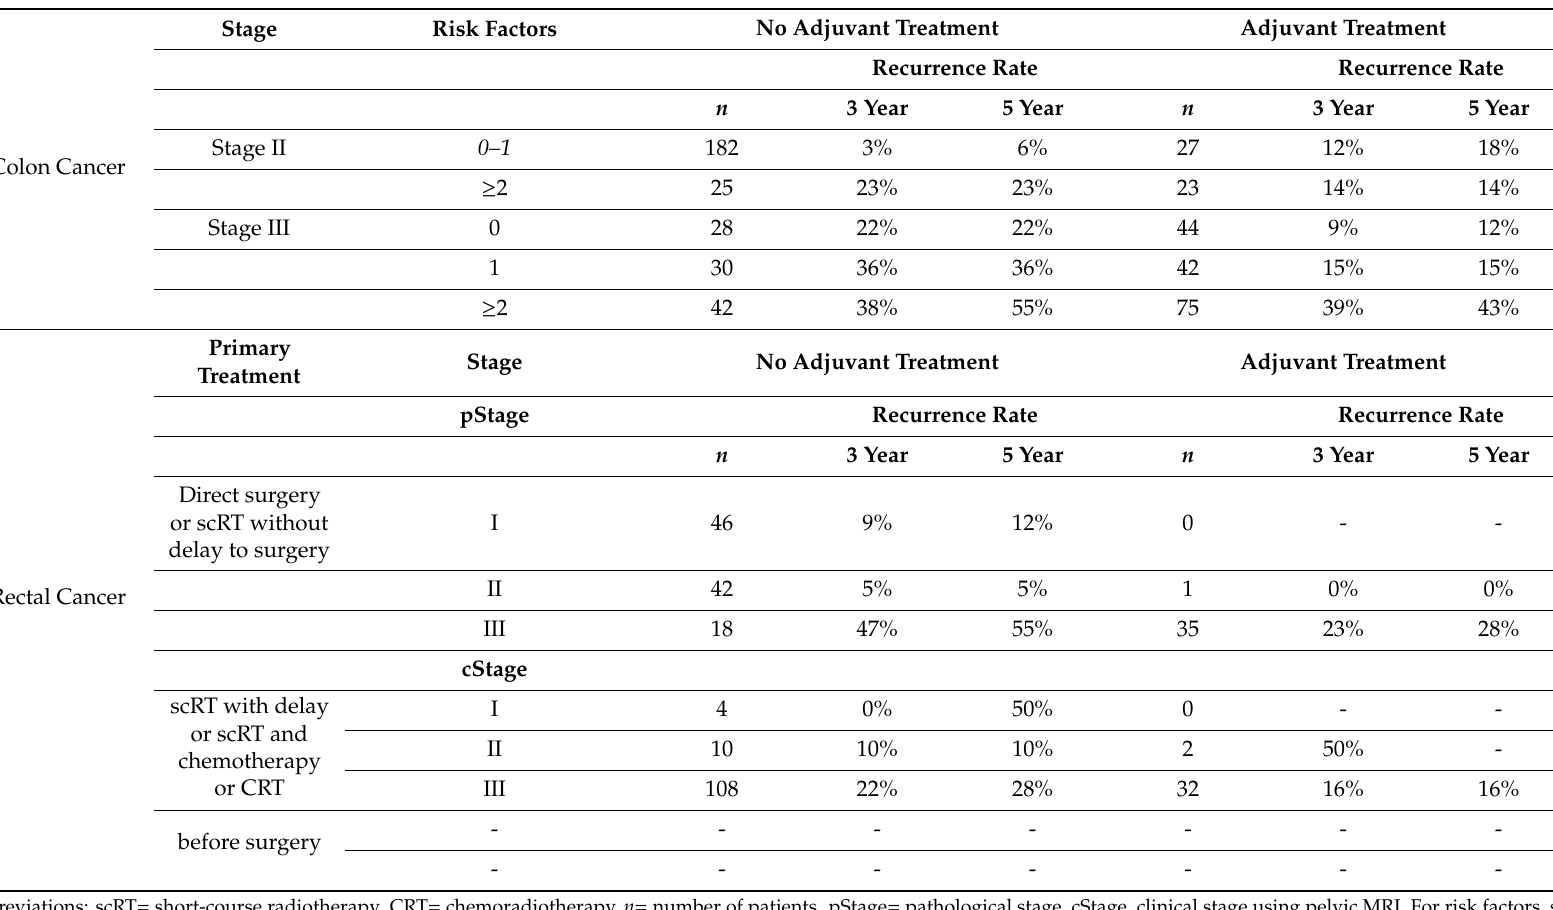
Table 7. Recurrence rates at 3 and 5 years after radical surgery in a Swedish population-based patient cohort diagnosed between 2010–2017 according to whether adjuvant therapy was initiated or